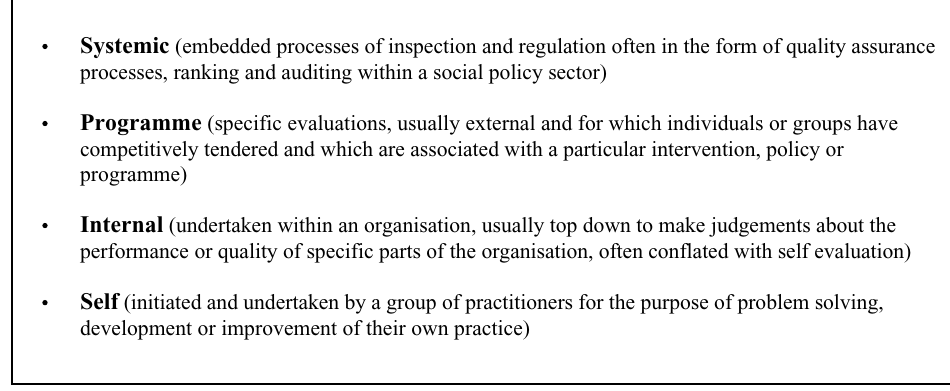
Figure 1. Clusters of evaluative